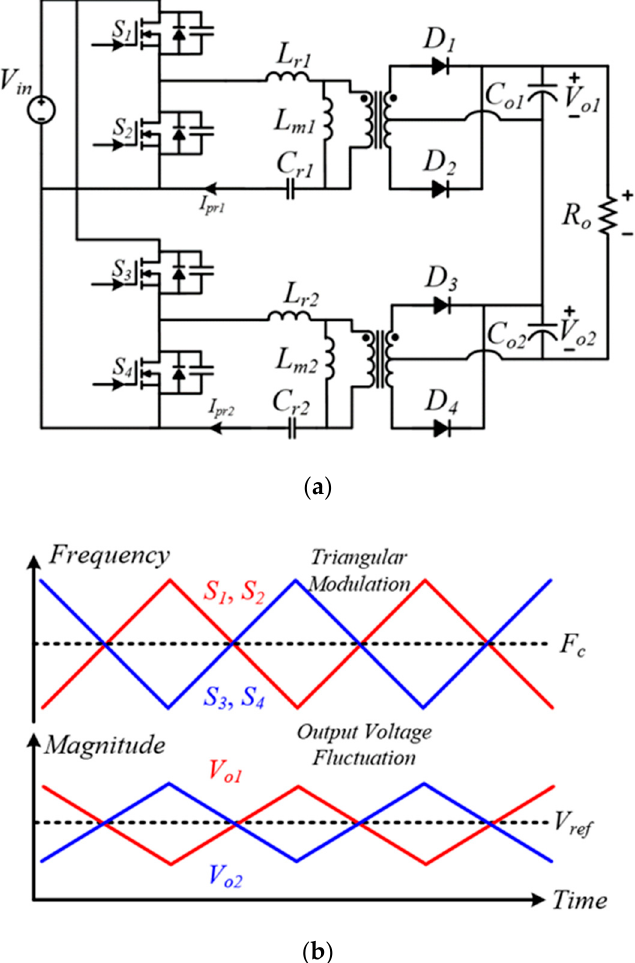
Figure 18. Parallel-series type LLC resonant converter shown in [52]: ( a ) system structure, and ( b ) control algorithm.